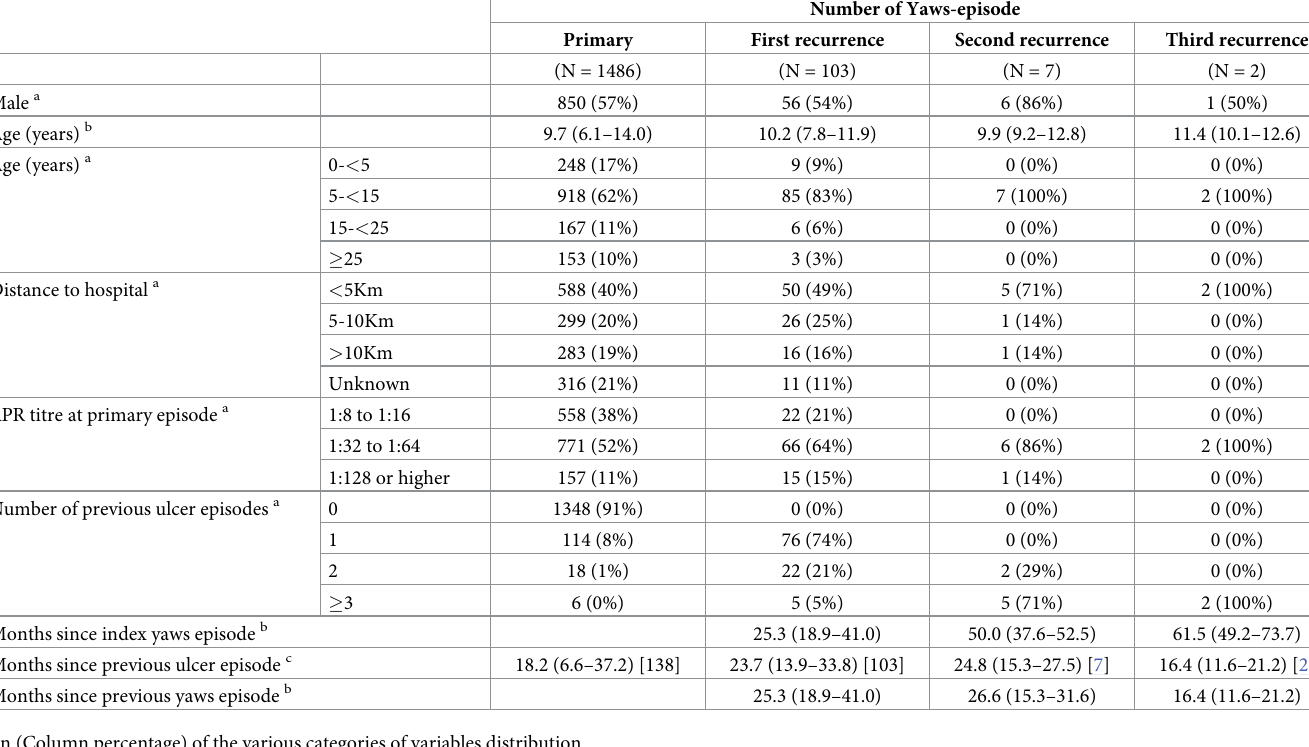
Table 1. Characteristics of patients included in the passive case detection analysis (i.e., retrospective screening of electronic health records).